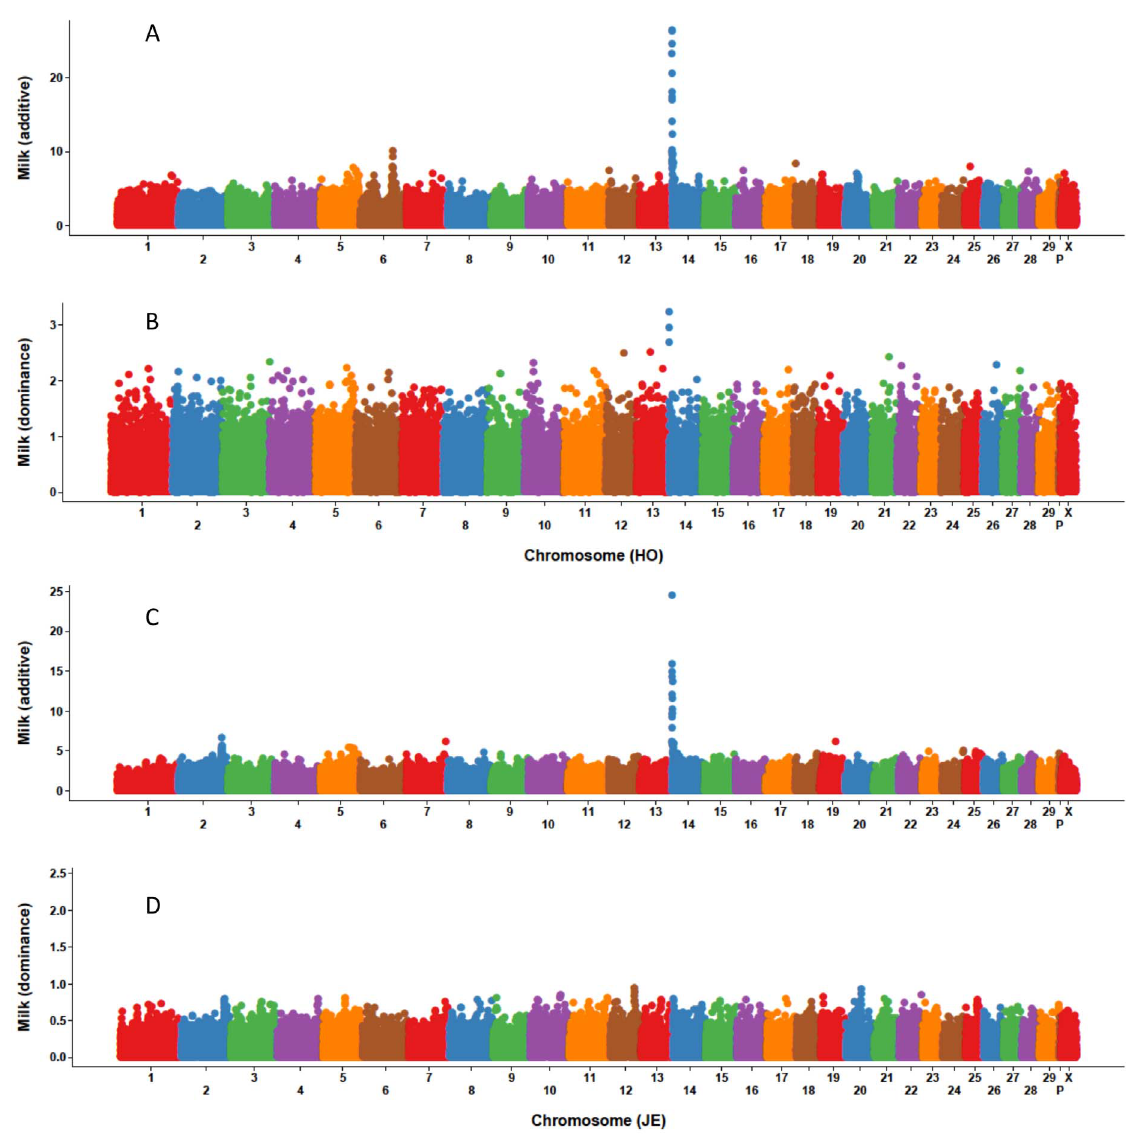
Figure 1. Size and location of marker additive and dominance effects for milk yield of Holsteins and Jerseys. Holstein additive (A) and dominance (B) effects and Jersey additive (C) and dominance (D) effects were estimated with a model that included additive and dominance (values) effects.